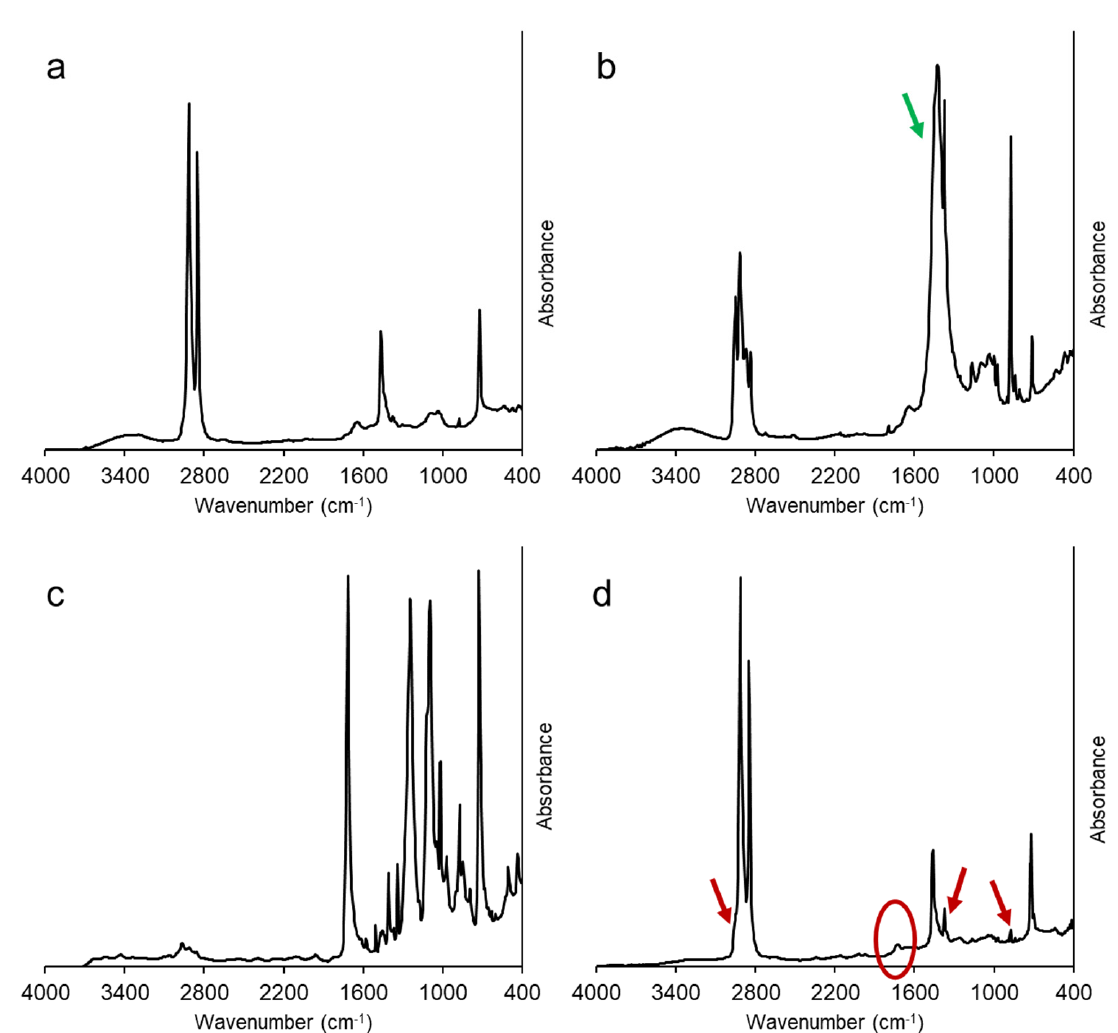
Figure 1. ATR-FTIR spectra of selected FIL/S film fragments ( a – c ) and of a film obtained after melt mixing and molding ( d ). In panel b, the signal attributed to calcium carbonate is indicated by a green arrow. In panel d, red arrows indicate polypropylene signals, while the small carbonyl peak is highlighted by a red ellipse. The majority of films analyzed showed the typical absorption of polyethylene (PE), as reported in Figure 1a, with strong peaks at 2916, 2850, 1470, and 720 cm − 1 due to CH 2 asymmetric and symmetric stretching, bending and rocking, respectively. The presence of some weaker bands in the spectrum can be related to additives (stabilizers and pigments) and surface contamination. The spectra of a minor family of film fragments, as in Fig- ure 1b, reveal the presence of polypropylene (PP) with the typical, composite absorption bands in the range 2980–2830 cm − 1 —in some cases, filled with inorganic additives, such as calcium carbonate, whose adsorption is indicated by the green arrow [20]. The